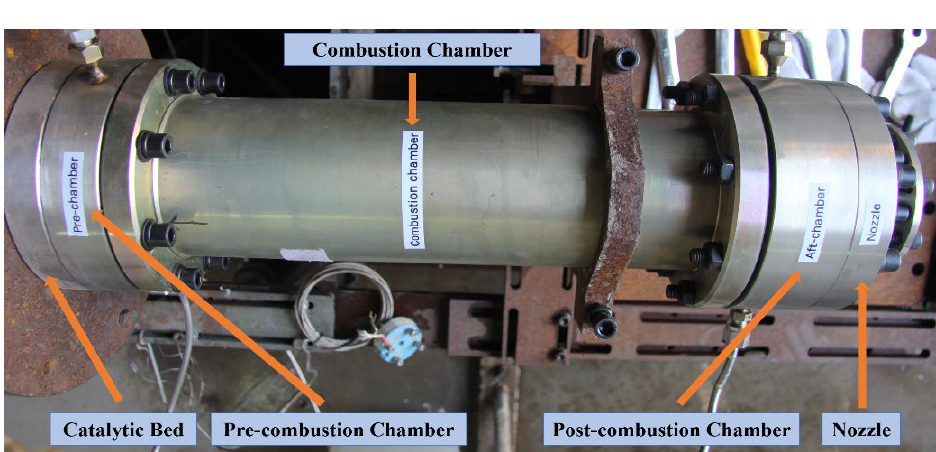
Figure 7. Picture of this HRM.